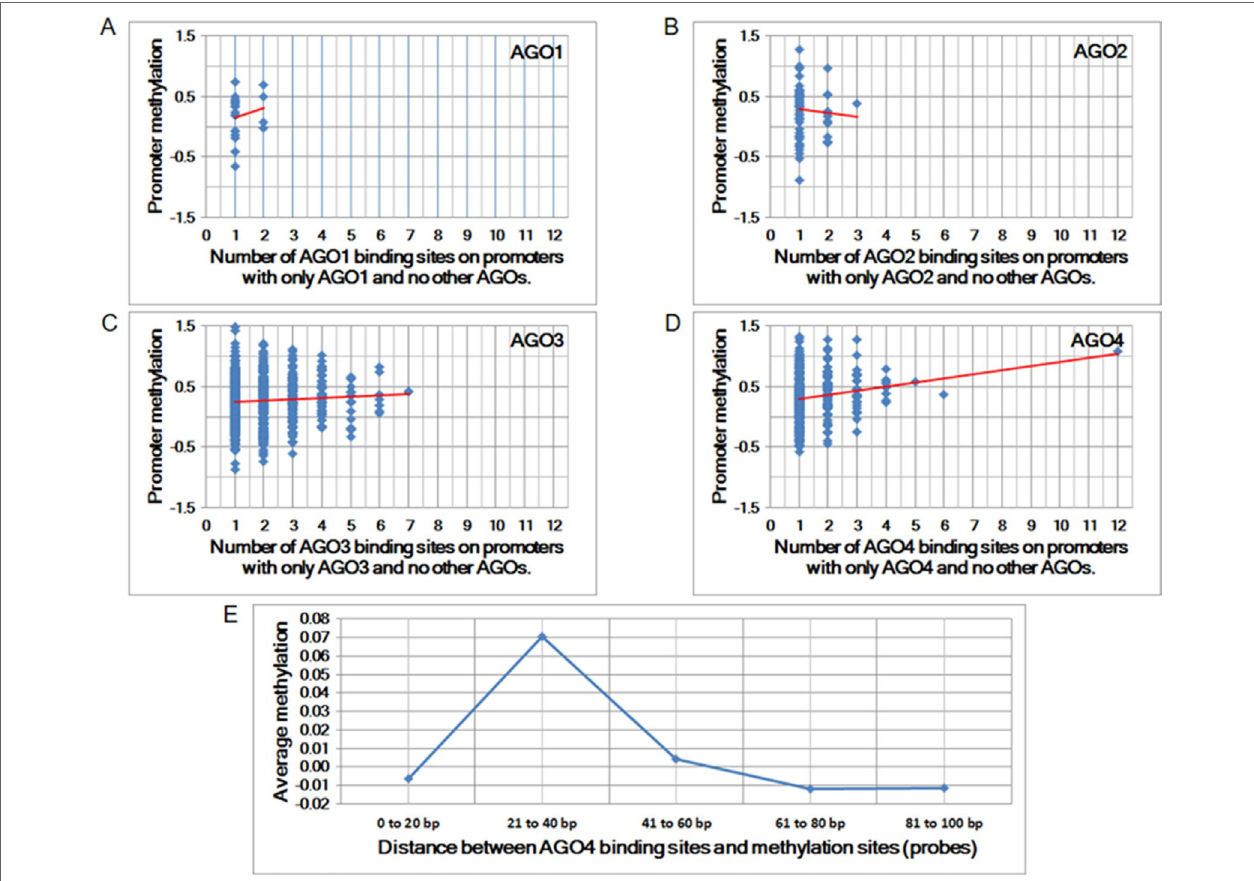
FIGURE 1 | The correlation between Argonaute (AGO) proteins and promoter methylation. (A to D) Promoter methylation vs. the number of AGO-binding sites. The Pearson correlation coefficients for A to D are 0.01, −0.06, 0.06, and 0.17, and the corresponding p -values are 8.63E-01, 6.51E-01, 1.11E-01, and 1.48E-03, respectively. (E) Average methylation vs. proximity to AGO-binding sites. Each column represents the average amount of methylation at a single probe if the proximity is within a predefined